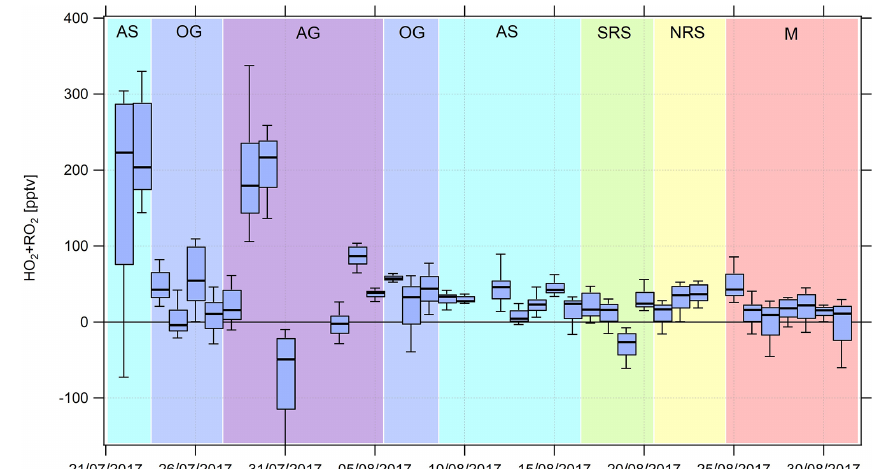
Figure 6. Timeline of the median ( HO 2 + RO 2 ) noontime estimates from 22 July to 31 August 2017. Due to contamination from the ship’s exhaust, there are no data from 18 to 21 July 2017. See Appendix A and the text for a list of the abbreviations used and a classification of the different regions, respectively.